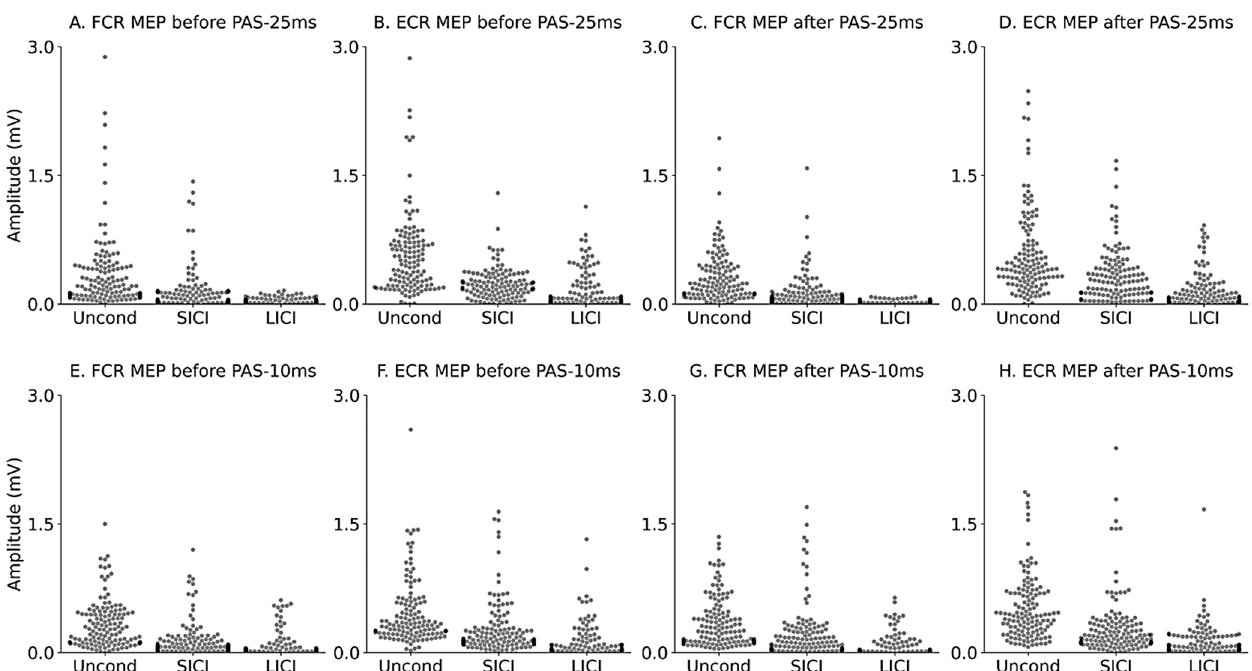
Figure 3. Scatter charts of MEP amplitudes for FCR ( A ) and ECR ( B ) before PAS-25 ms, those for FCR